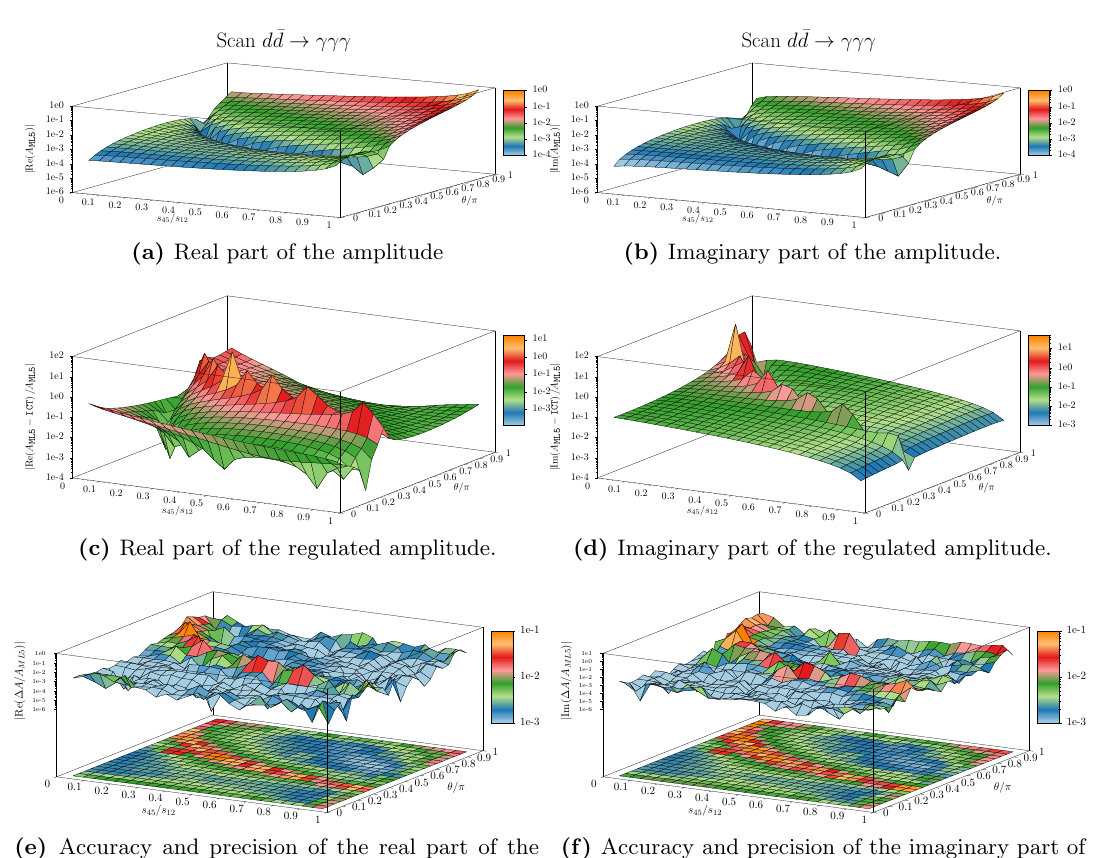
Figure 23. A scan for d (cid:22) d (cid:13) 1 (cid:13) 2 (cid:13) 3 . The results are absolute values plotted on a log scale. The ! (cid:12)rst row (a{b) shows the real and the imaginary part of the amplitude computed with ML5 . The second row (c{d) shows the relative di(cid:11)erence between the analytic expression and the integrated counterterms. The last row (e{f) shows the LTD integration. They are a combination of two plots: the surface above shows the relative error of the central value compared with the analytic expression, the (cid:13)at surface below shows the Monte Carlo error for the point right